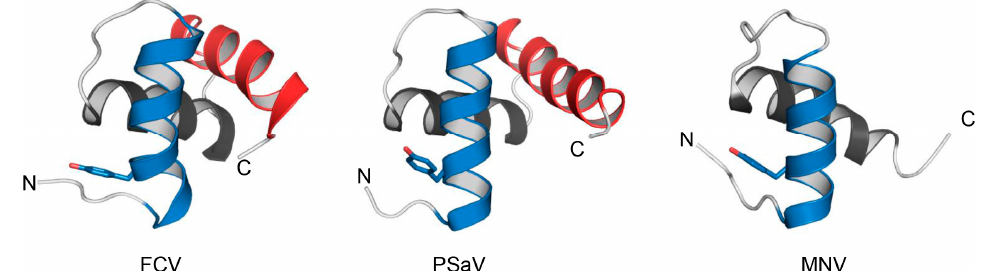
Figure 2. Solution structures of caliciviral VPgs. Cartoon representation of a representative model of each of the structured cores of the Feline Calicivirus (FCV), Porcine Sapovirus (PSV), and Murine Norovirus (MNV) VPg proteins. Each of these models have been deposited in the RCSB data base The N-terminal, middle and C-terminal helices are coloured blue, black and red respectively. The side-chain of the proposed nucleotide accepting tyrosine is shown as sticks in each